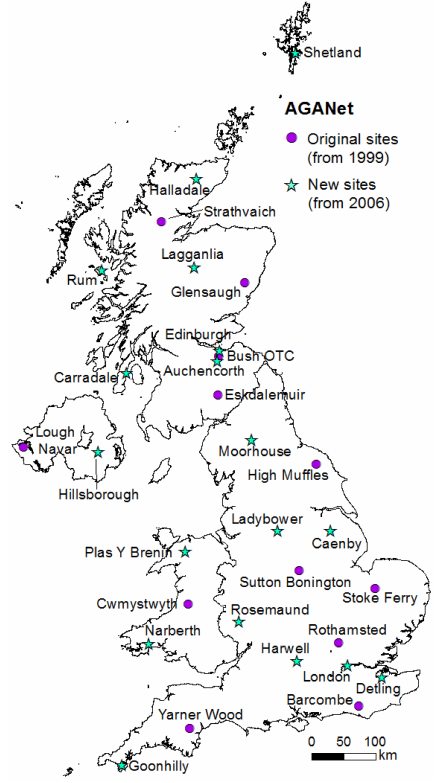
Figure 1. Site map of the UK Acid Gases and Aerosol Network (AGANet). The AGANet was established in September 1999 with 12 sites and expanded to 30 sites from January 2006 to improve na- tional coverage. These sites also provide measurements of NH 3 and NH + for the UK National Ammonia Monitoring Network (NAMN, 4 Tang et al.,